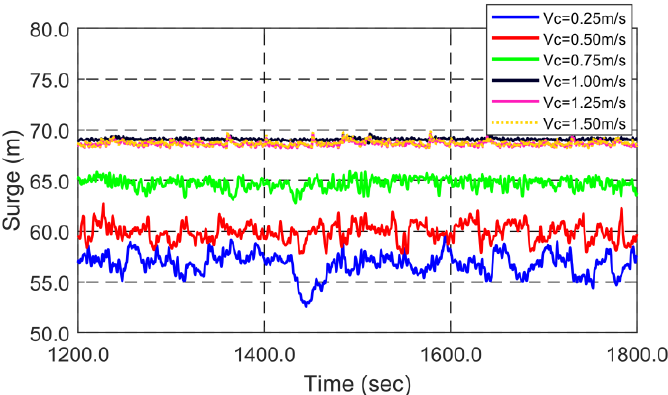
Figure 8. Time histories of surge motion of the location buoy at different current velocity under identical wave excitations ( H s = 1.0 m, T p = 5.25 sec). Appl. Sci. 2018 , 8 , x FOR PEER REVIEW